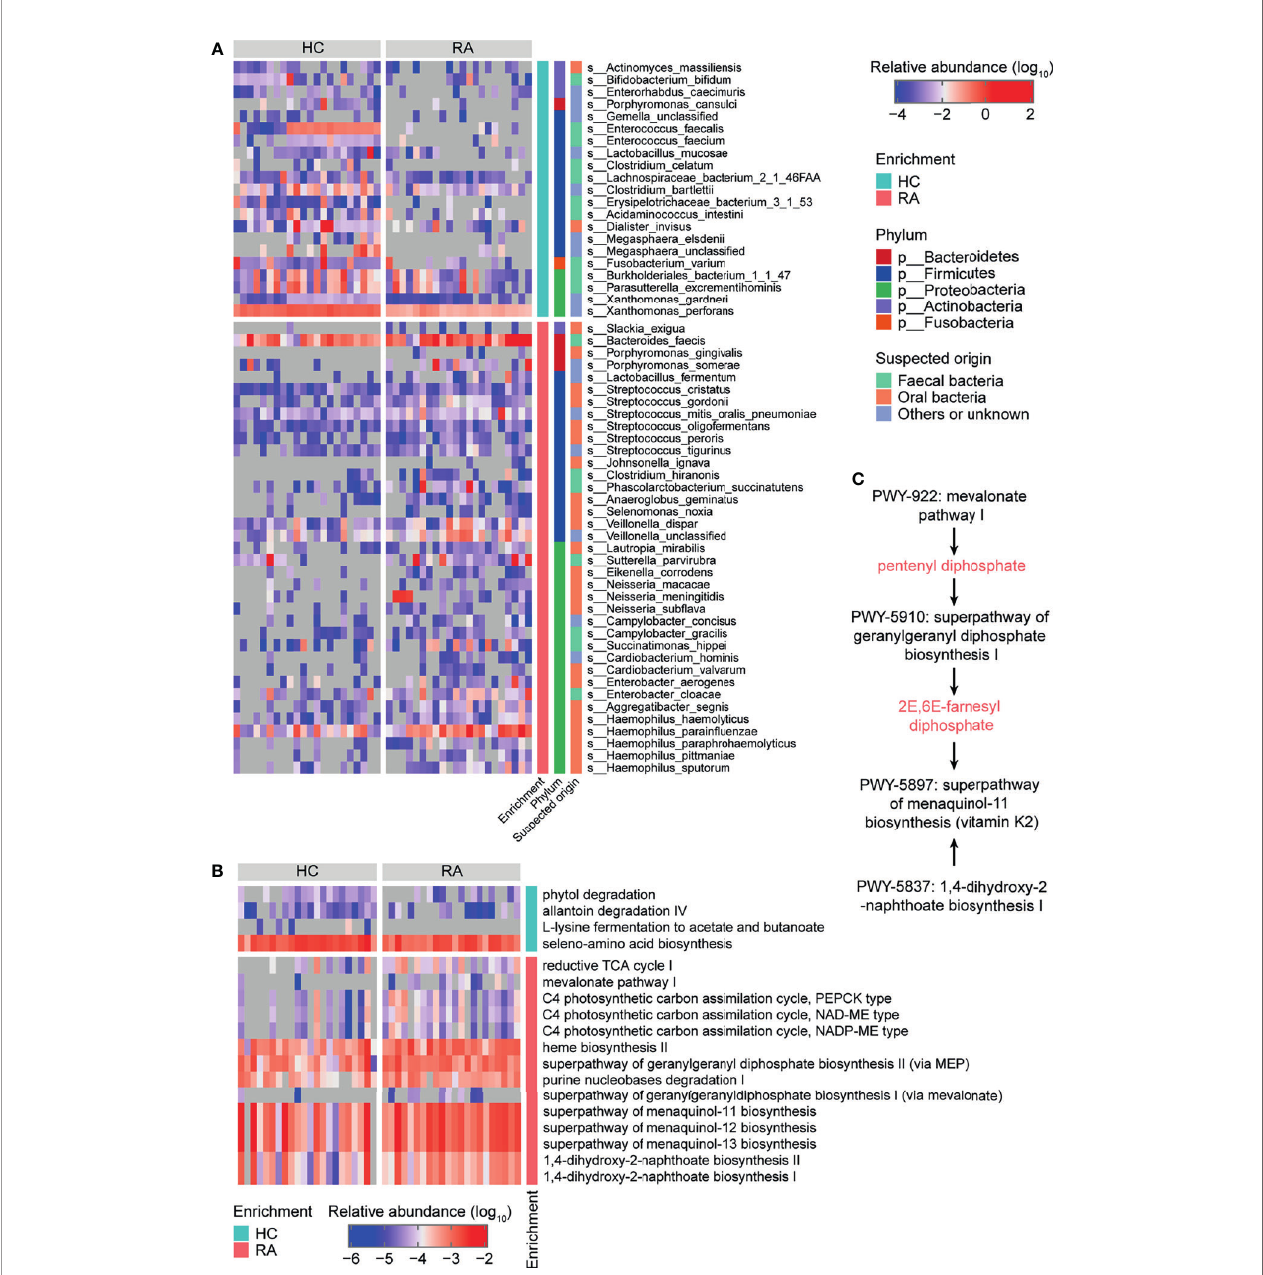
FIGURE 1 | Taxonomy and function of gut microbes that varied between rheumatoid arthritis (RA) patients and healthy controls (HCs) at baseline. Heatmaps of differentially abundant (A) bacterial species and (B) MetaCyc metabolic pathways in the RA group compared to the HC group. (C) MetaCyc vitamin K biosynthesis- related